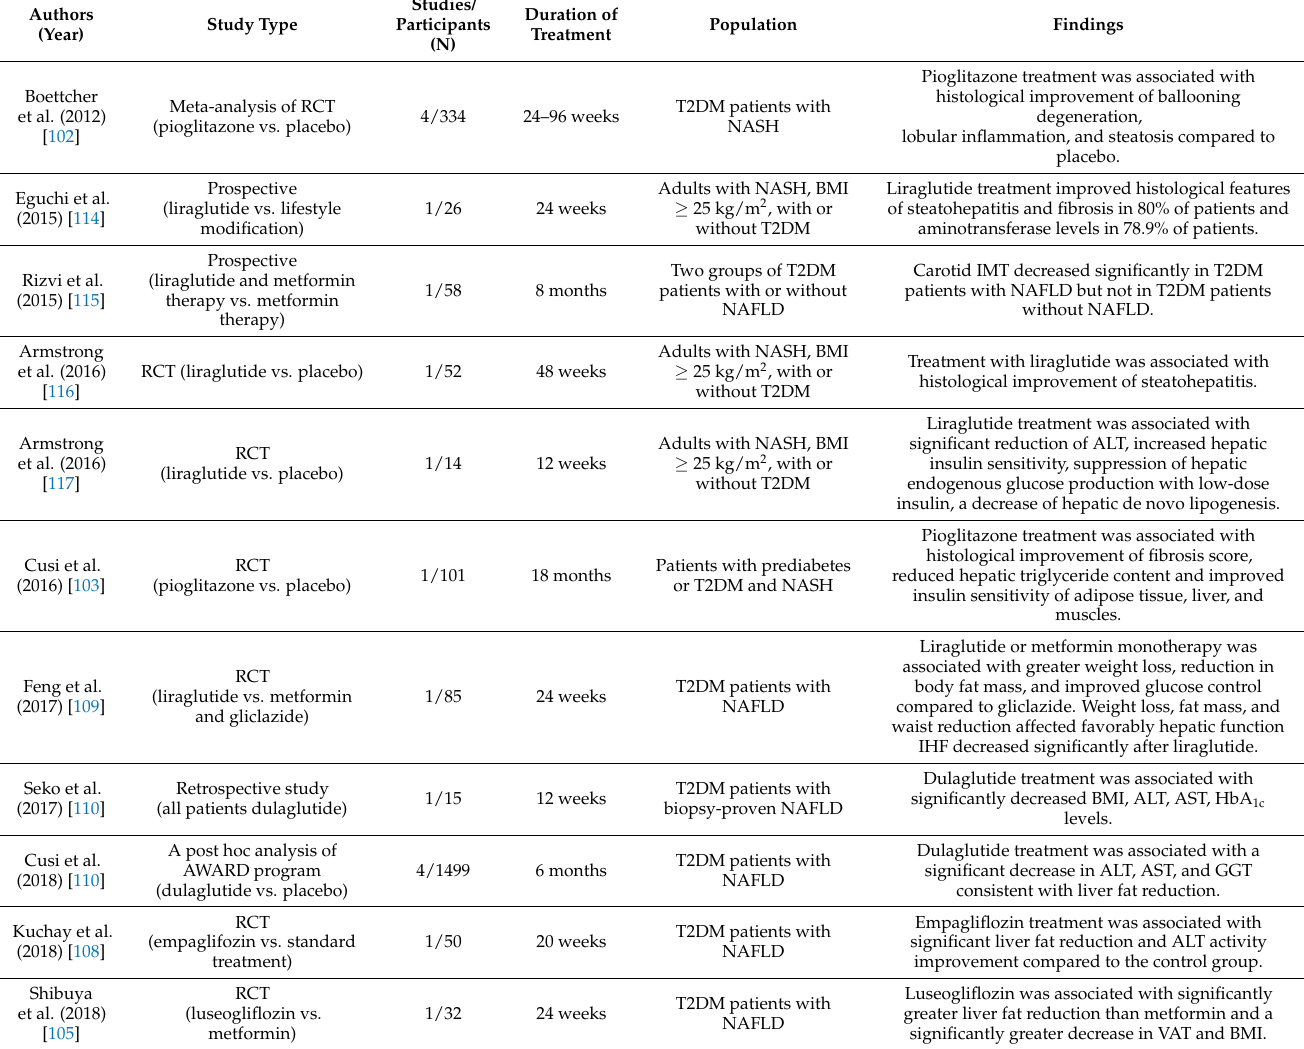
Table 5. NAFLD and NASH treatment with antidiabetic